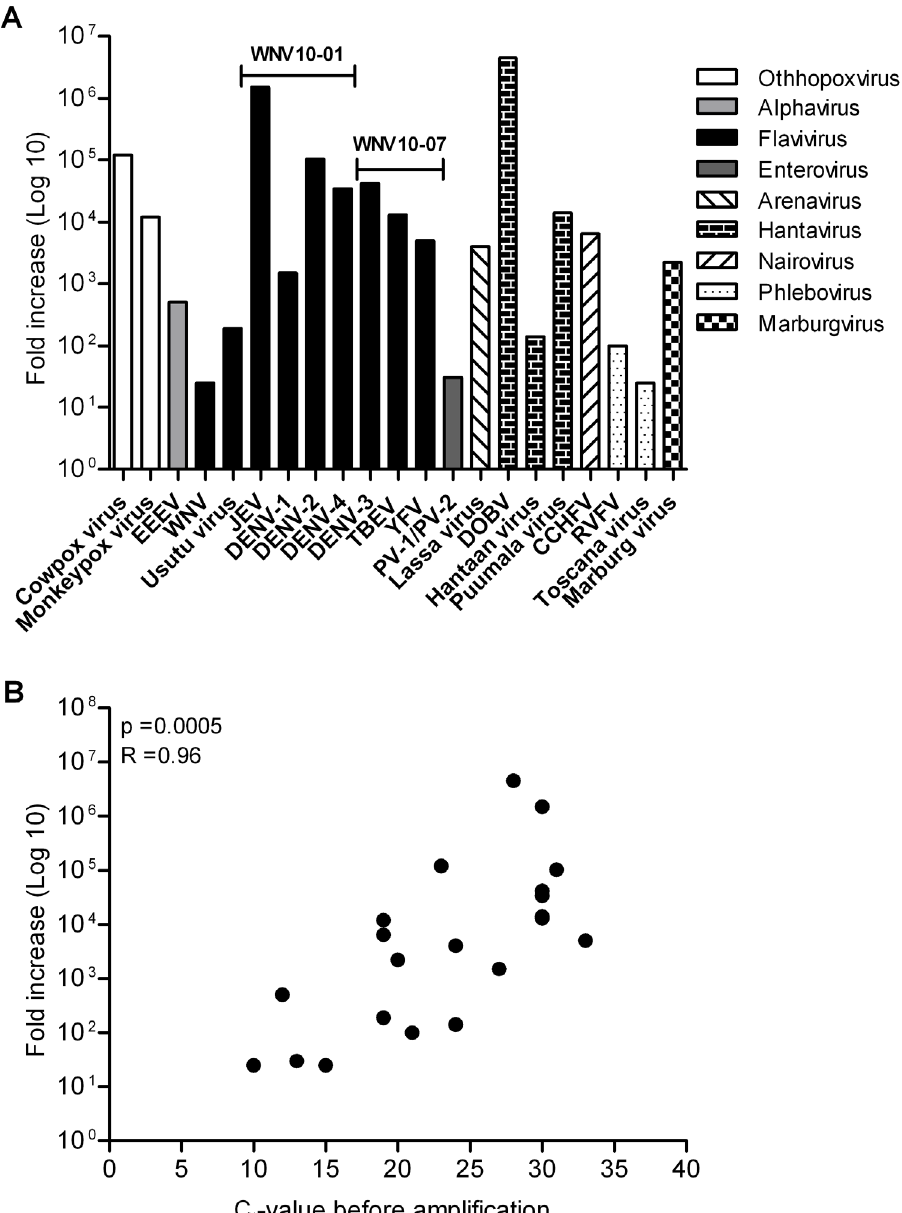
Figure 2. Modified WT amplification of non-clinical samples containing emerging virus. Purified viral RNA from a wide range of virus- positive cell culture supernatants (SN) or QCMD panel samples was amplified by WTA using the P-N6/SSIII RT-reaction. Virus-specific real-time PCR was performed before and after the amplification step, and fold increase was calculated using D C t -values and dilution factors for each sample tested. (A) Fold increase of WT-amplified emerging viruses belonging to different virus genera. The two QCMD panel samples (WNV10-01 and WNV10-07) containing mixtures of different flaviviruses are highlighted. (B) The correlation between fold increase in WT amplification and viral sample content (C t before WT amplification).